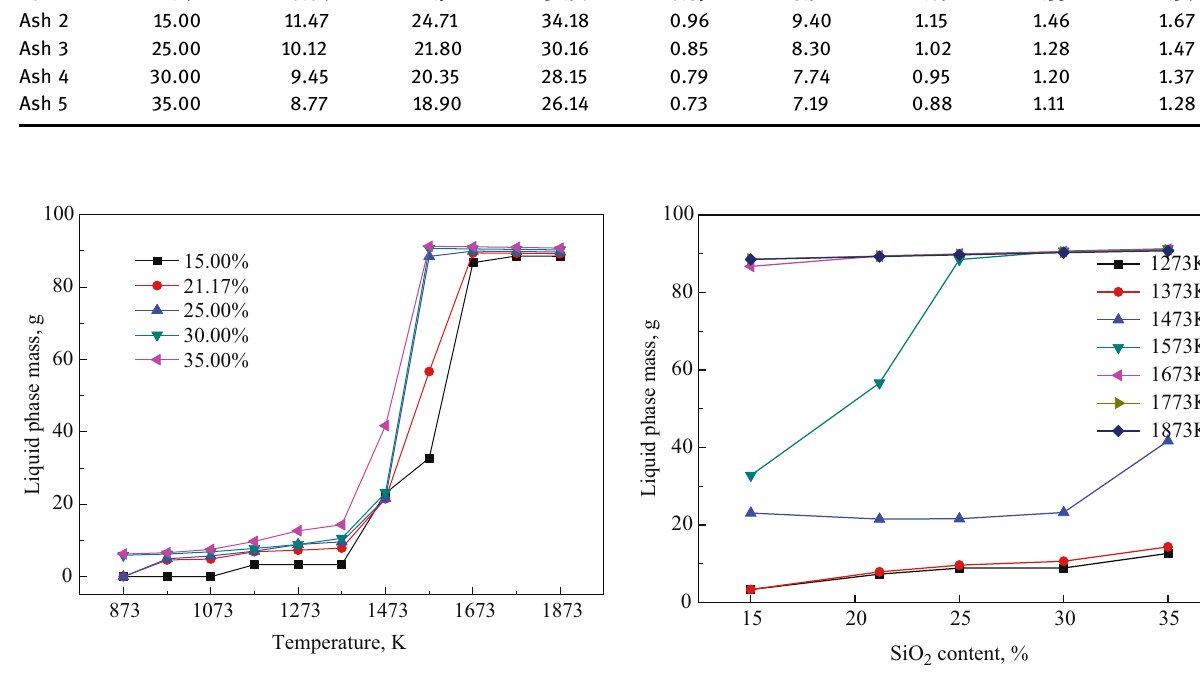
Figure 15: Relationship between liquid production and temperature under di ff erent SiO 2 contents.